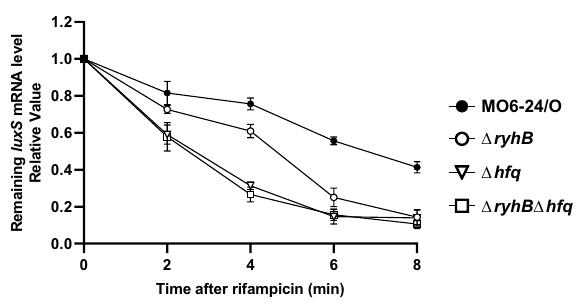
Figure 6. Effects of RyhB on the stability of luxS mRNA. Effects of RyhB and Hfq on the stability of luxS mRNA. The relative levels of luxS mRNA following rifampicin treatment were measured using qRT-PCR. V. vulnificus MO6, ryhB mutant (Δ ryhB ), hfq mutant (Δ hfq ) or ryhB , hfq double mutant (Δ ryhB Δ hfq ) were cultured in AB broth for 5 h until reaching an A 600 of 0.3. Samples were then collected at 0, 2, 4, 6, and 8 min after the addition of rifampicin (500 μg/ml), and RNA was quantified by